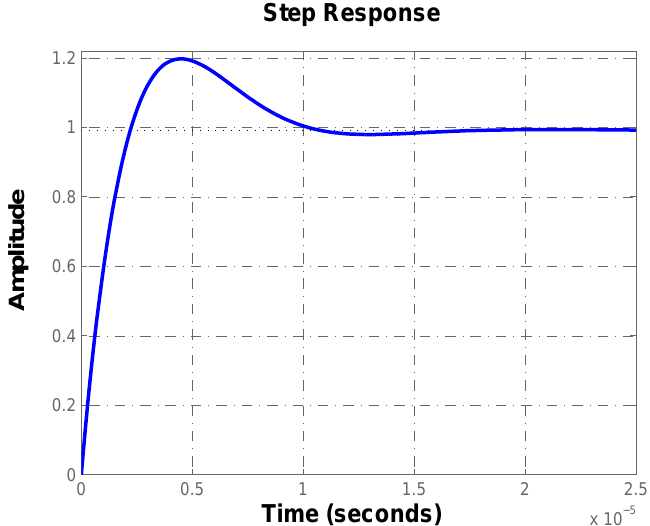
Figure 3. Closed-loop step response of the boost converter produced by the synthesized fractional- order controller (18).